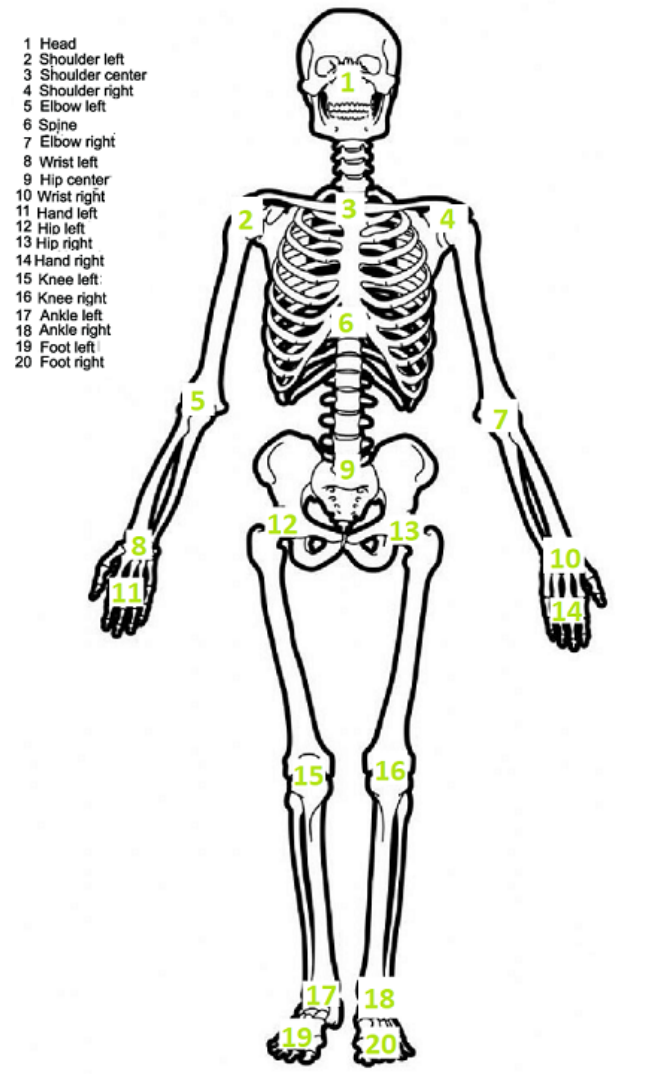
Figure 2. The names are assigned to human joints using the Microsoft